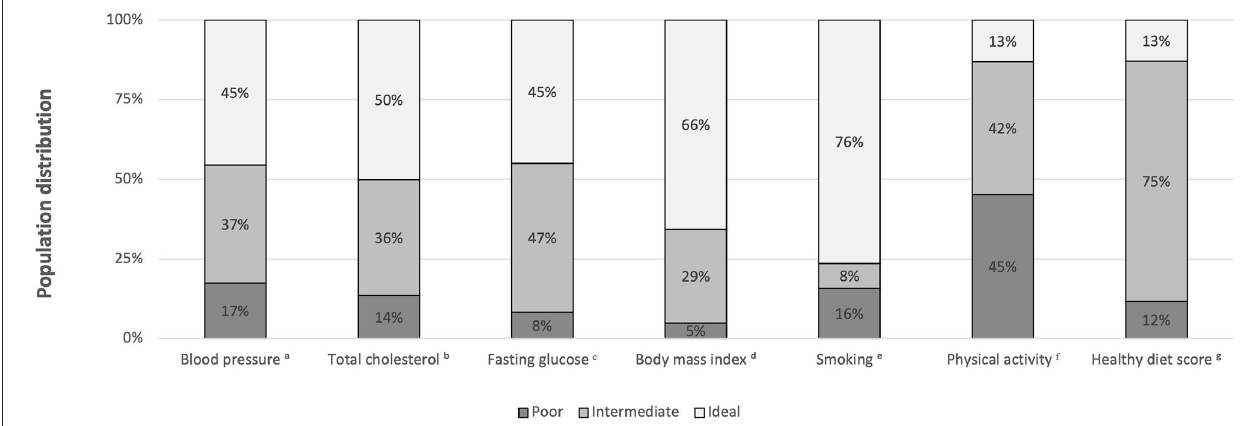
FIGURE 2 | Distribution of each component of the CVH metric in the total analyzed population (vegetarians plus non-vegetarians). BP, blood pressure; SBP, systolic blood pressure; DBP, diastolic blood pressure; BMI, body mass index. a Ideal, intermediate, poor BP were defined as SBP < 120 mmHg and DBP < 80 mmHg, SBP 120-139 mmHg or DBP 80-89 mmHg or treated to goal, and SBP ≥ 140 mmHg or DBP ≥ 90 mmHg, respectively. b Ideal, intermediate, poor total cholesterol were defined as < 200 mg/dL, 200–239 mg/dL or treated to goal, and 240 mg/dL, respectively. c Ideal, intermediate, poor fasting glucose were defined as < 100 mg/dL, 100–125 mg/dL, and ≥ 126 mg/dL, respectively. d Ideal, intermediate, poor body mass index (BMI) were defined as < 25 kg/m 2 , 25–29.9 kg/m 2 , and ≥ 30 kg/m 2 , respectively. e Ideal, intermediate, poor smoking status were defined as never smokers, past smokers, and current smokers, respectively. f Ideal, intermediate, and poor physical activity were defined as ≥ 210 min/week, 60-210 min/week, and < 60 min/week, respectively. g Ideal, intermediate, and poor healthy diet scores were defined as 4–5 components, 2–3 components, and 0–1 components,